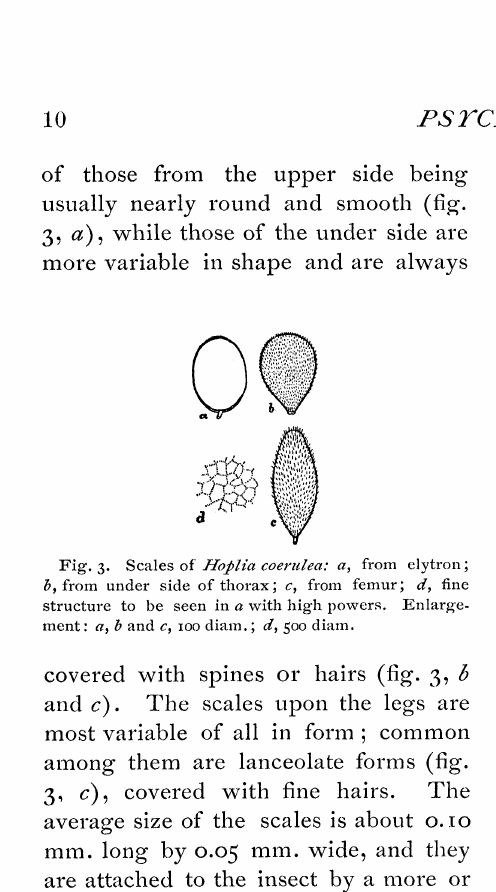
Fig. 3. Scales of H@l[a coerulea: a, from elytron" b, from under side of thorax; c, from femur; d, fine structure to be in with high powers. Enlarge- ment a, and c, diam. d, 500